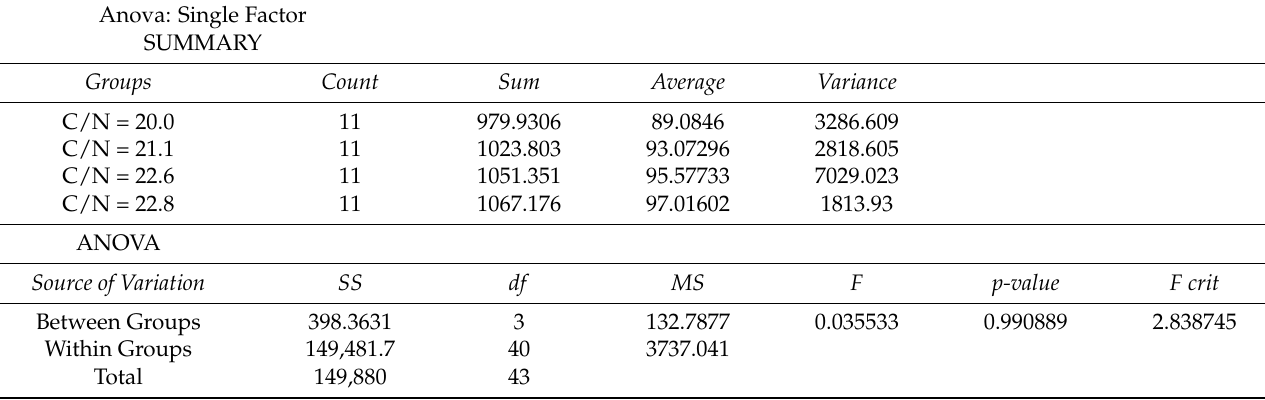
Table A5. One-way (ANOVA) test for methane yield every three days from the first four